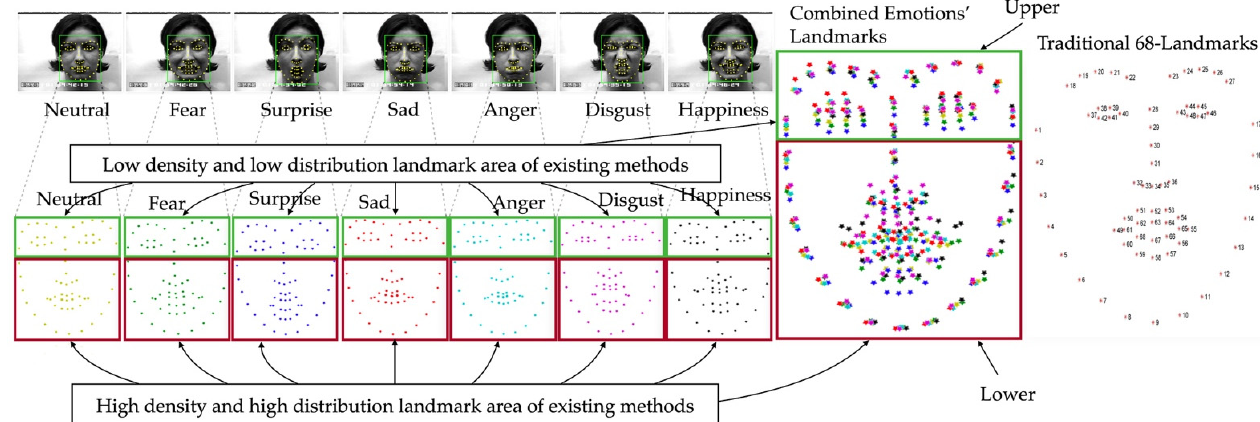
Figure 2. Traditional landmarks.